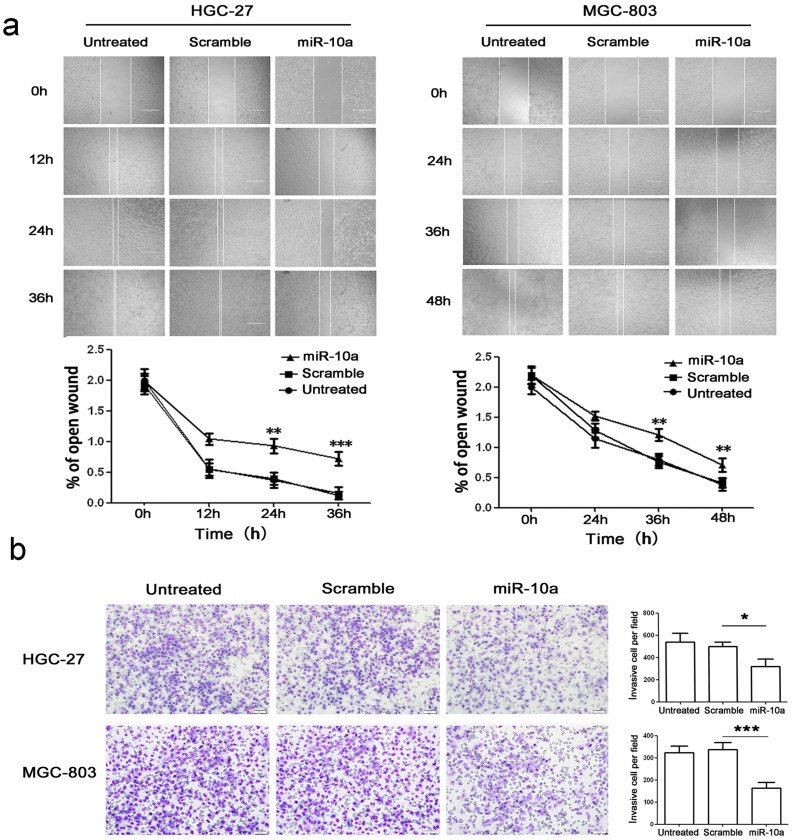
miR-10a inhibits cell migration and invasion in vitro.
a HGC-27 and MGC-803 cells were untreated or transfected with 50 nmol/L scramble or miR-10a for 24 h, and wounds were made. The relative ratio of wound closure per field is shown at 0, 12, 24, 36, 48 hours. Bar, 500 µm. b HGC-27 and MGC-803 cells were untreated or transfected with 50 nmol/L scramble or miR-10a for 24 h, and a transwell invasion assay was performed. The relative ratio of invasive cells per field is shown. Bar, 50 µm and 100 µm. All data are presented as the means ± SD. *, P<0.05; **, P<0.01, ***, P<0.001.